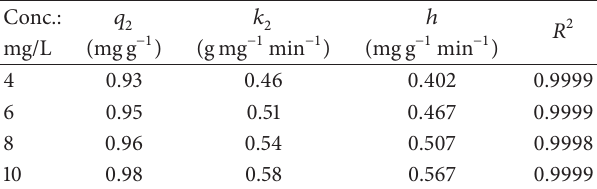
Table 6: Pseudo-second-order kinetic parameters of various kinet- ics parameters for the adsorption of MB onto C. polygonoides at different initial dye concentrations.